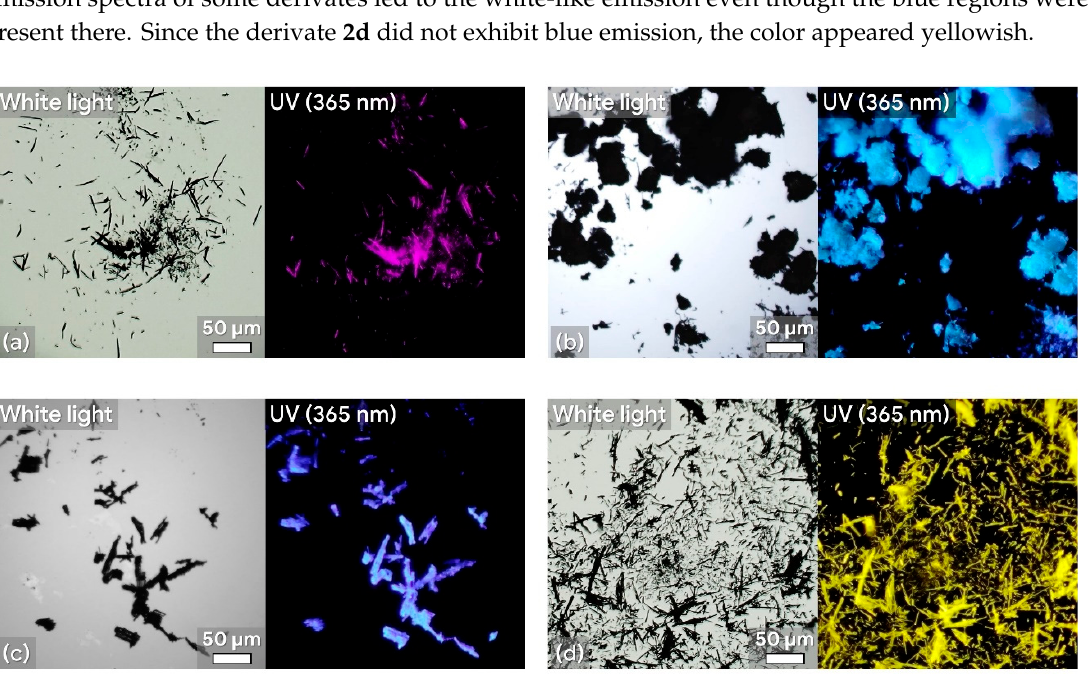
Figure 8. Micrographs of synthesized carboline derivatives 2a – 2d under visible (white) light and UV light (365 nm). The micrographs illustrate the crystals and photoluminescence of ( a ) 2a , ( b ) 2b , ( c ) 2c , and ( d ) 2d .